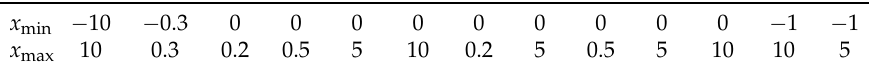
Table B1. The bounds of the